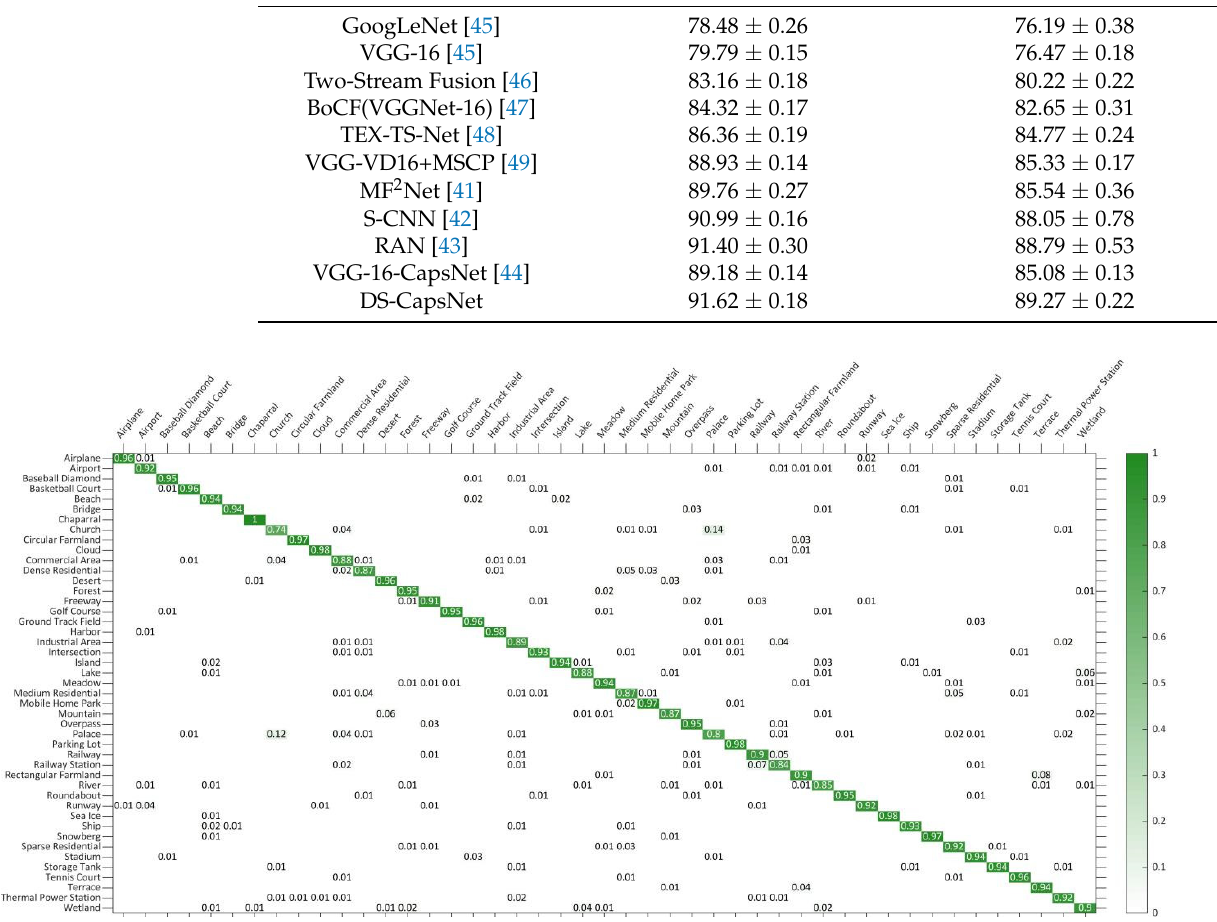
Figure 14. CM on NWPU-RESISC45 dataset under 2:8 training ratio.